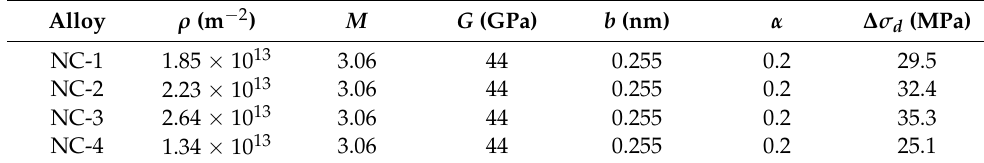
Table 6. Relevant parameters and theoretical values of the dislocation